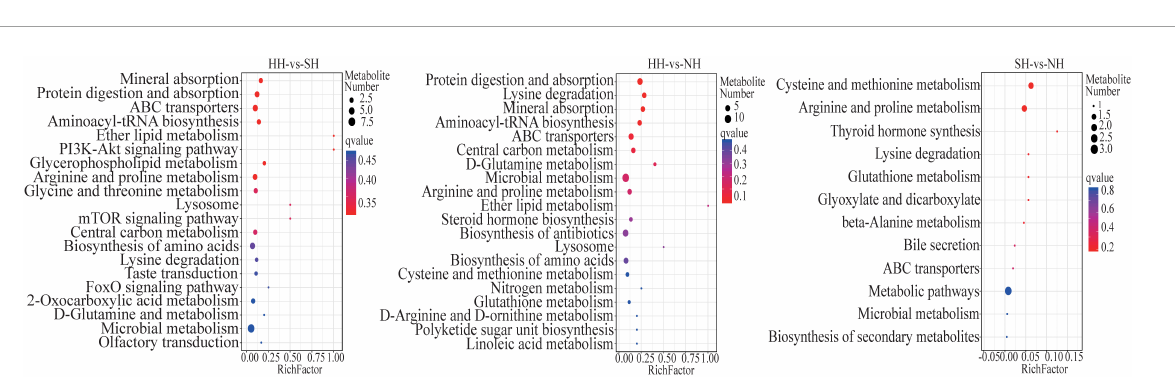
FIGURE4 Bubble diagram of top 20 KEGG pathway enrichment in HH-SH, HH-NH, and SH-NH comparisons. The ordinate indicates the